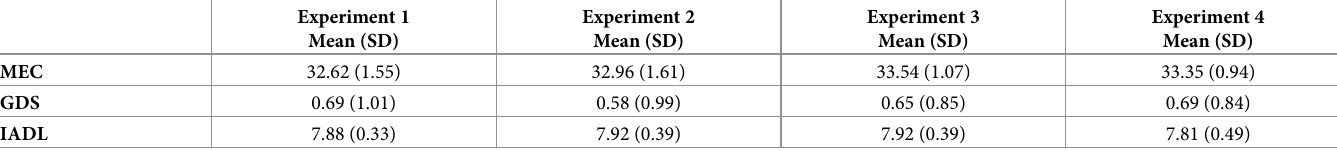
Table 1. Screening scores for the older participants in Experiments 1 to